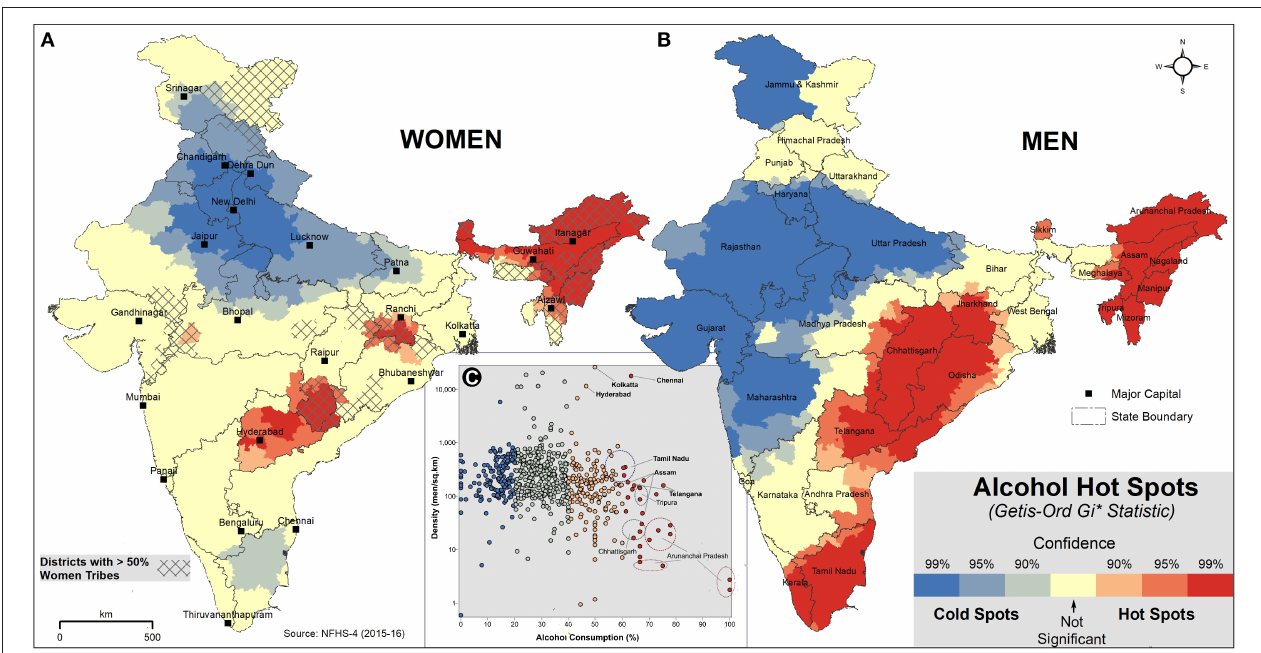
FIGURE 2 | Hot spot analysis of alcohol consumption in India, NFHS-4. The hot (red) and cold (blue) spots of alcohol consumption with three confidence levels (99, 95, and 90%) are shown for women (A) and men (B) . The light yellow color shows the spatially not-significant districts of alcohol consumption. The overlaid hatches (A) indicate that more than 50% of women are ST in that district. Scatter plot (C) shows the relationship between alcohol consumption and density. The dots represent district values of alcohol consumption of men (%) and men density per